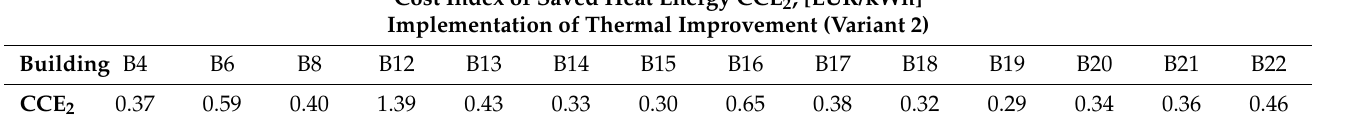
Table 17. Value of cost index of saved energy for heating after thermal improvement only (weather control) CCE 2 , [EUR/kWh].